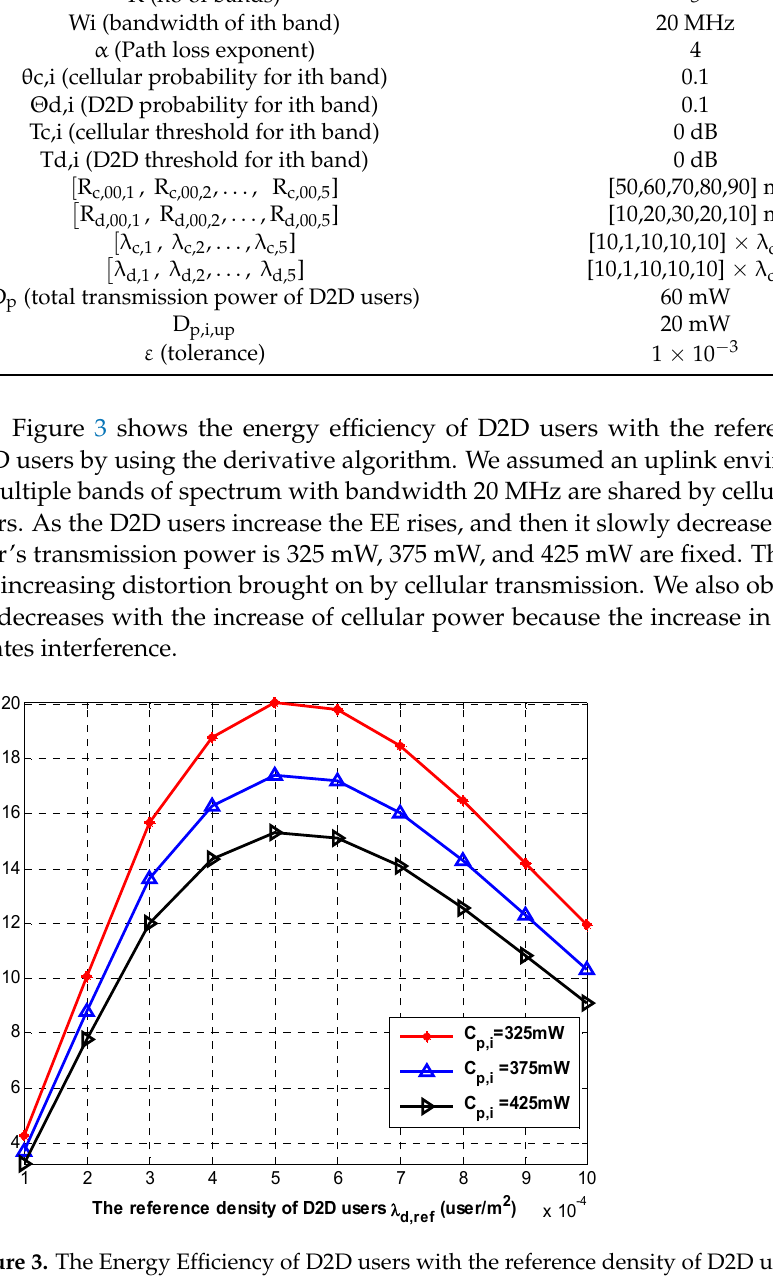
Table 1. Simulation parameters by using the derivative algorithm.